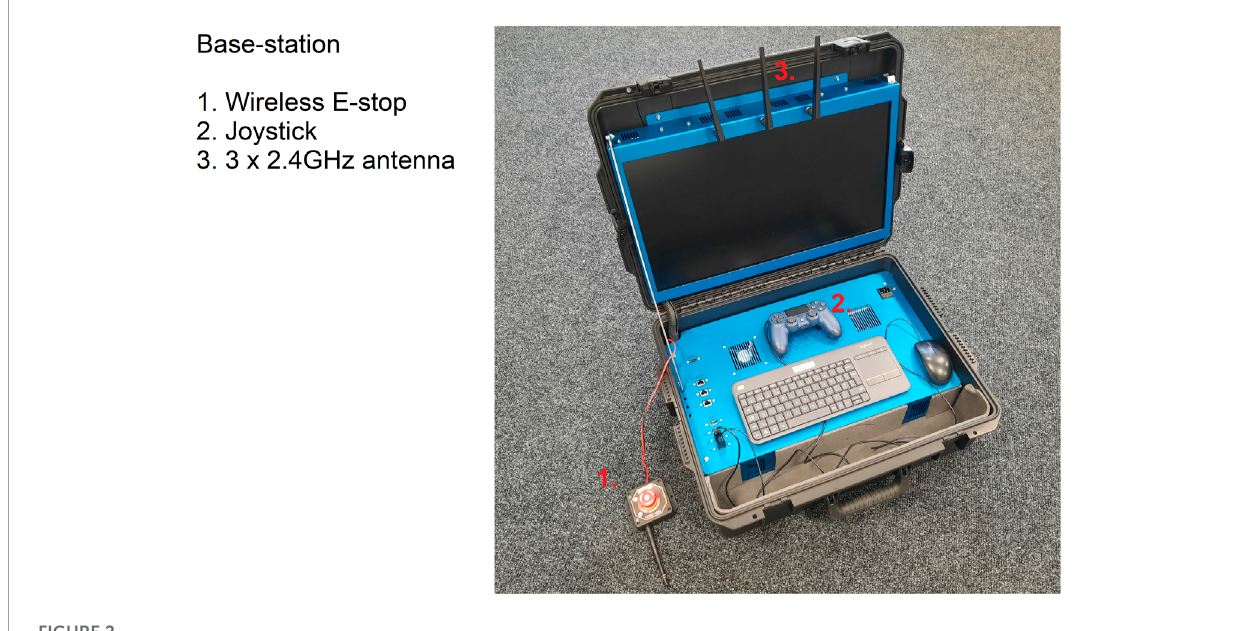
FIGURE 2 The base-station developed to control the CARMA II platform.